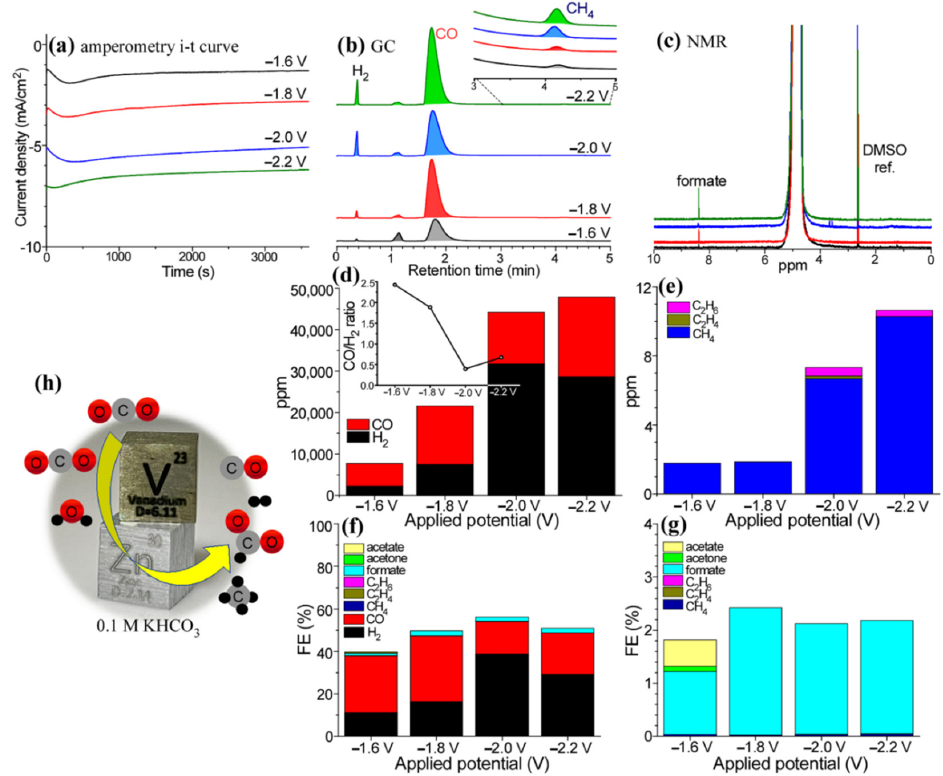
Figure 1. Amperometry i-t curves over V-Zn(H) hybrid electrodes at applied potentials of − 1.6 V, − 1.8 V, − 2.0 V, and − 2.2 V (vs. Ag/AgCl) ( a ). GC profiles after the amperometry tests ( b ). NMR spectra for liquid products after the amperometry tests ( c ). CO and H 2 production amount with applied potentials ( d ). CH 4 , C 2 H 4 , and C 2 H 6 amounts with applied potentials ( e ). Corresponding FEs including liquid products (( f ) and ( g ), respectively). Scheme for CO 2 reduction process over V-Zn hybrid material ( h